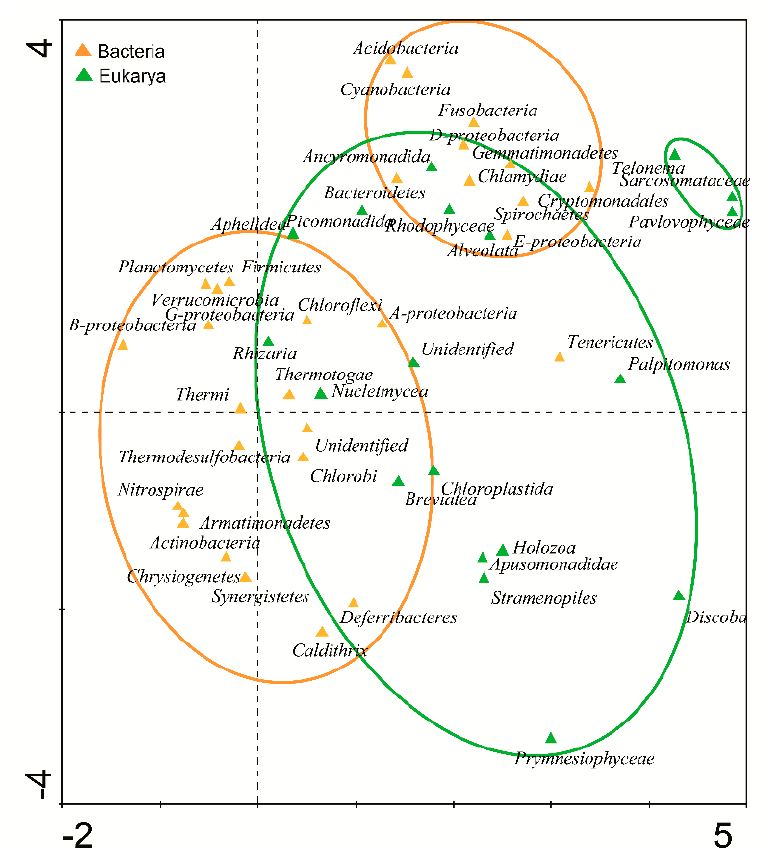
Figure 3. The relative abundances of the microbial phyla of bacteria and microeukaryotes were analyzed by detrended corresponded analysis (DCA). The diagram displays triangles that represent phyla of bacteria (orange) and microeukaryotes (green). Venn diagrams cluster and discriminate areas in which bacteria (orange diagrams) or microeukaryotes (green diagrams) are more abundant.